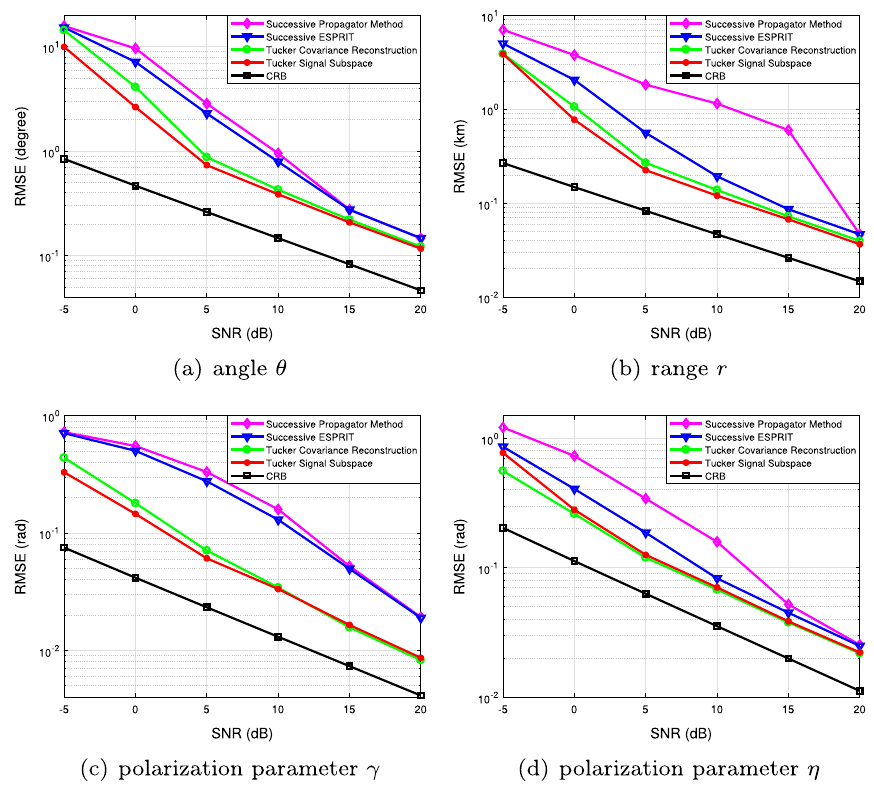
Fig. 5 RMSE versus SNR for range, angle and polarization estimation using different methods. M = 6 , N = 6 , P = 3 , L = 5 and 500 independent trials. (θ , r ) = ( 40 ◦ ,4km ) , ( − 30 ◦ ,2km ) , ( 10 ◦ ,5km ) and (γ , η) = (π/ 10, π/ 5 )(π/ 5,3 π/ 5 )(π/ 4,2 π/ 5